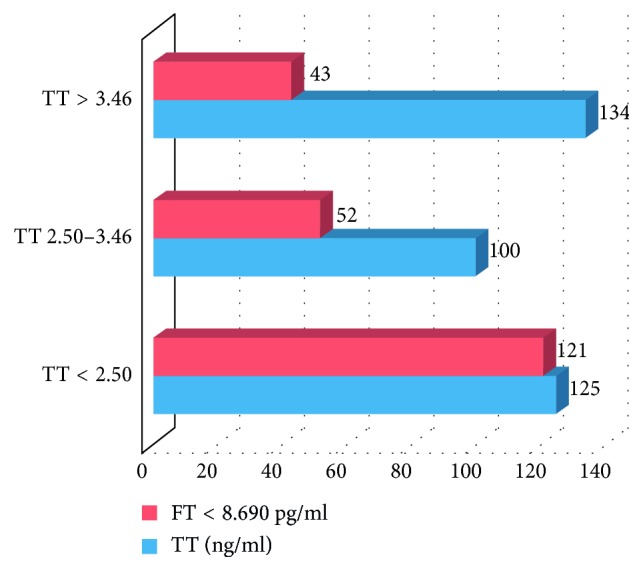
Graph showing association between TT and FT levels in the study population.